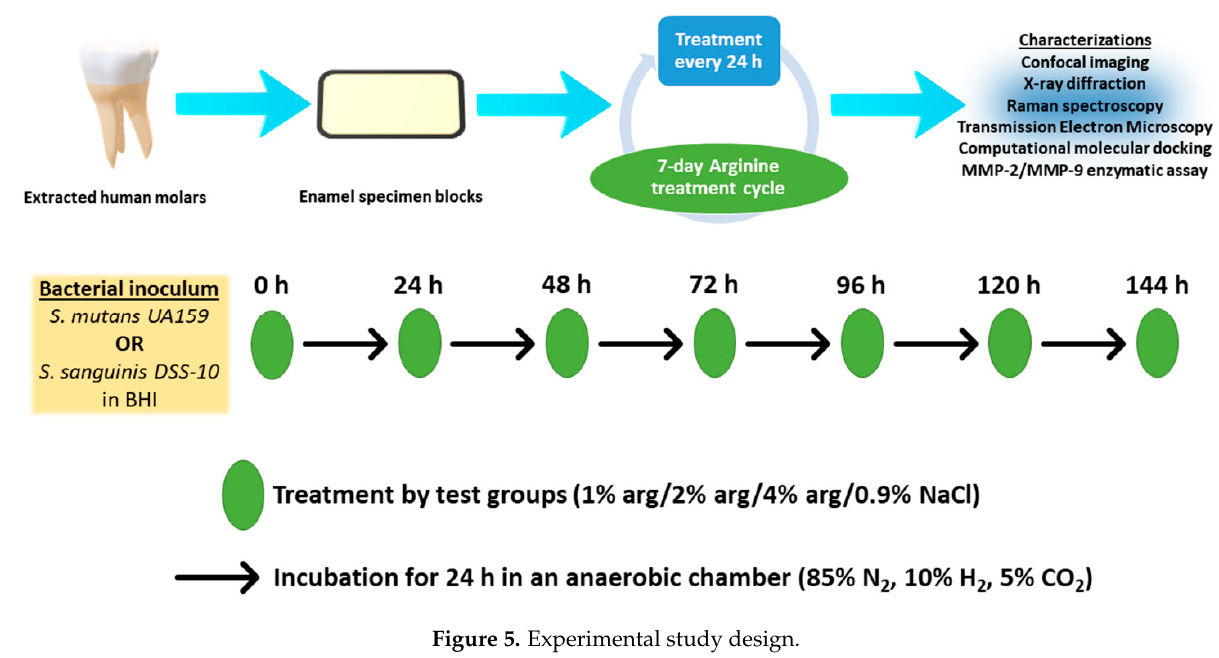
Figure 5. Experimental study design.